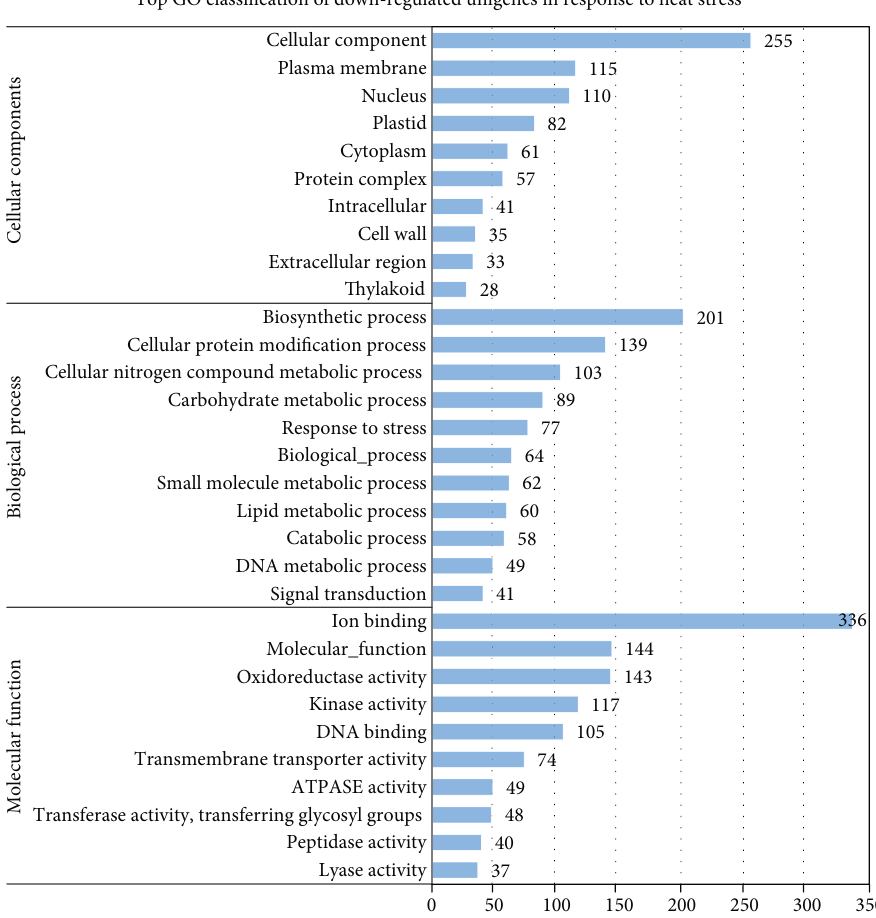
Figure 7: GO classi fi cation of the downregulated genes detected in leaf tissues of the guar accession under heat